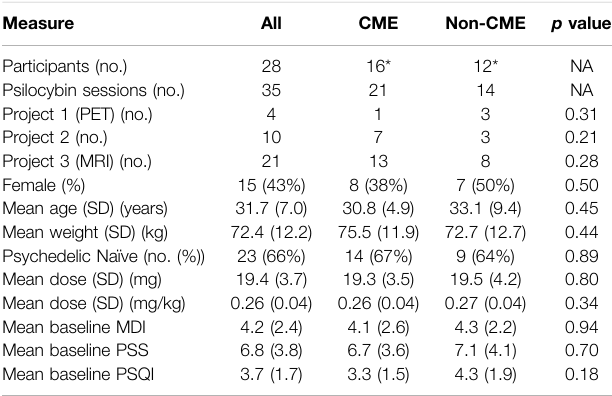
TABLE 1 | Descriptive statistics of the participants split by Complete Mystical Experience